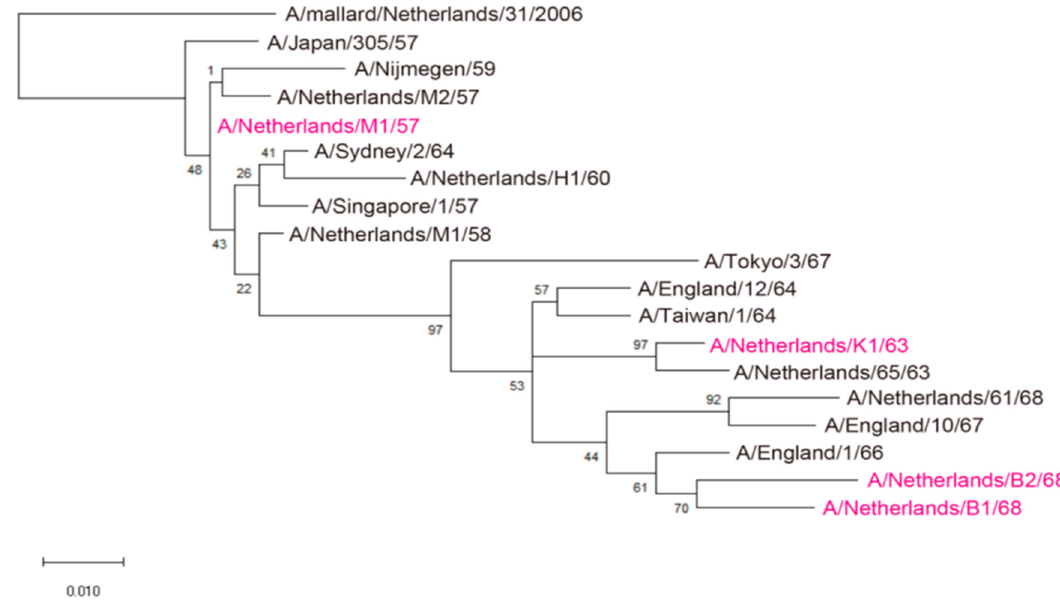
Figure 1. Phylogenetic tree based on the amino acid sequences of HA1 derived from human H2N2 viruses. This tree was constructed by using the Maximum Likelihood method and JTT matrix-based model. Virus isolates used for antigenic analysis are highlighted in magenta. Table 2. Neutralization titers of aged and younger adult individuals.